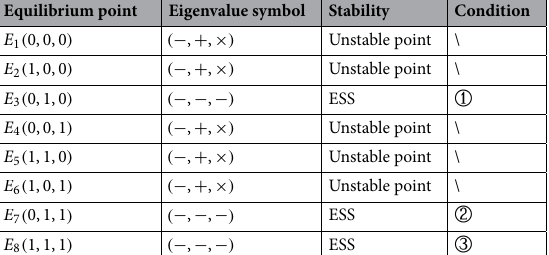
Table 4. Stability analysis of equilibrium point. x indicates uncertain symbol, condition: ①